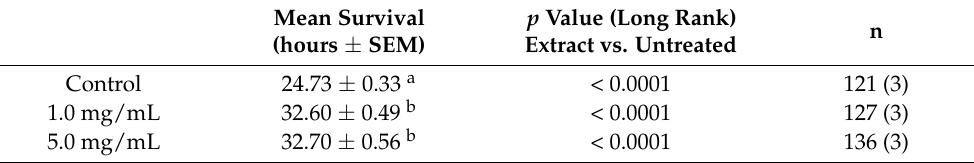
Table 1. Evaluation of resistance to oxidative stress in nematodes treated with BT. p Value (Long Rank) Mean Survival (hours ± SEM) Extract vs. Untreated Control